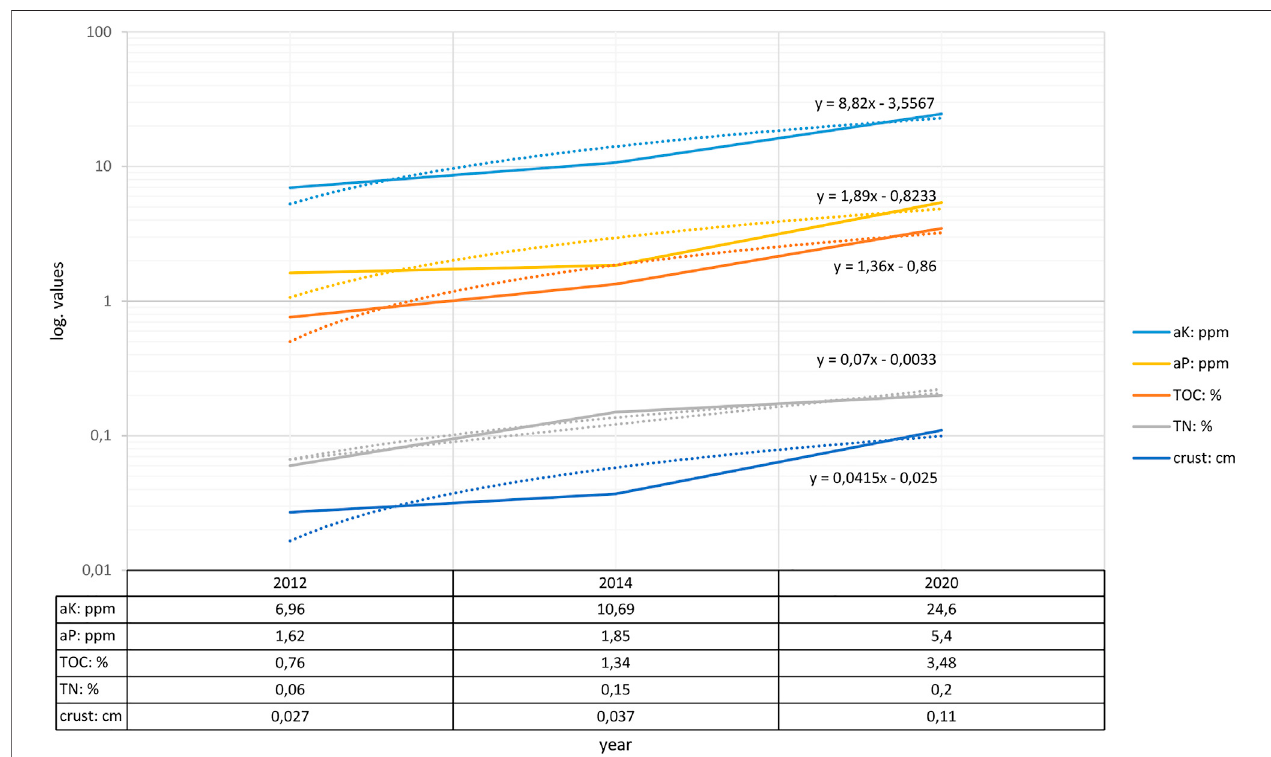
FIGURE3| Meanvaluesofsoilparametersandbiocrustin2012,2014,and2020( n =5-10).Linearregressioninlogarithmictransformation(dotted)withequation.